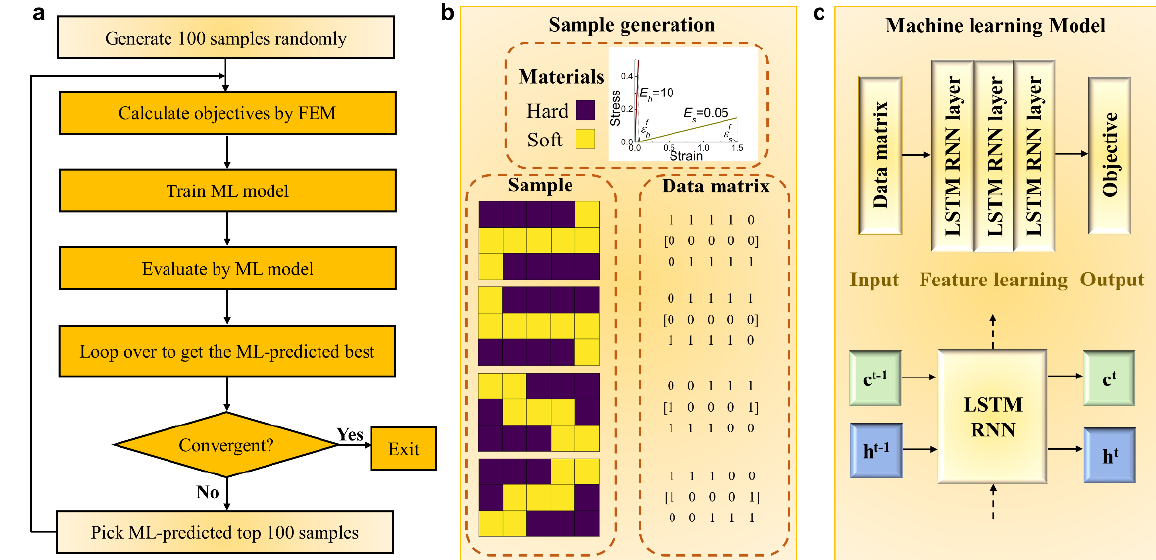
Figure 1. System schematic of the LSTM-based optimal strategy. ( a ) Flow chart. ( b ) Sample generation. The sample is composed of two kinds of materials with different linear elastic mechanical properties: hard material colored by purple ( E h = 10.0 GPa, ε f h = 0.05) and soft material colored by yellow ( E s = 0.1 GPa, ε f s = 1.5). The presented samples are the FEM-calculated top 4 sample configurations, which belong to the calculation domain discretized into 15 blocks and the material ratio of hard to soft fixed as 8/15. With blocks occupied by hard material and soft material expressed as 1 and 0 respectively, a data matrix composed of 0 and 1 can be adopted to represent each sample. ( c ) The construction of long short-term memory based machine learning model. Data matrixes composed of 0 and 1 that depict the distribution of hard and soft materials are input features. The hidden layers are followed by two LSTM layers for feature learning and one LSTM layer for regression. The objective (single value) is the output property. Each LSTM RNN layer possesses two states, which are cell state and hidden state.